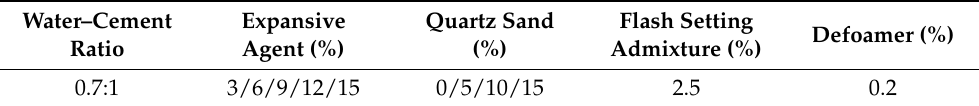
Table 2. Test scheme